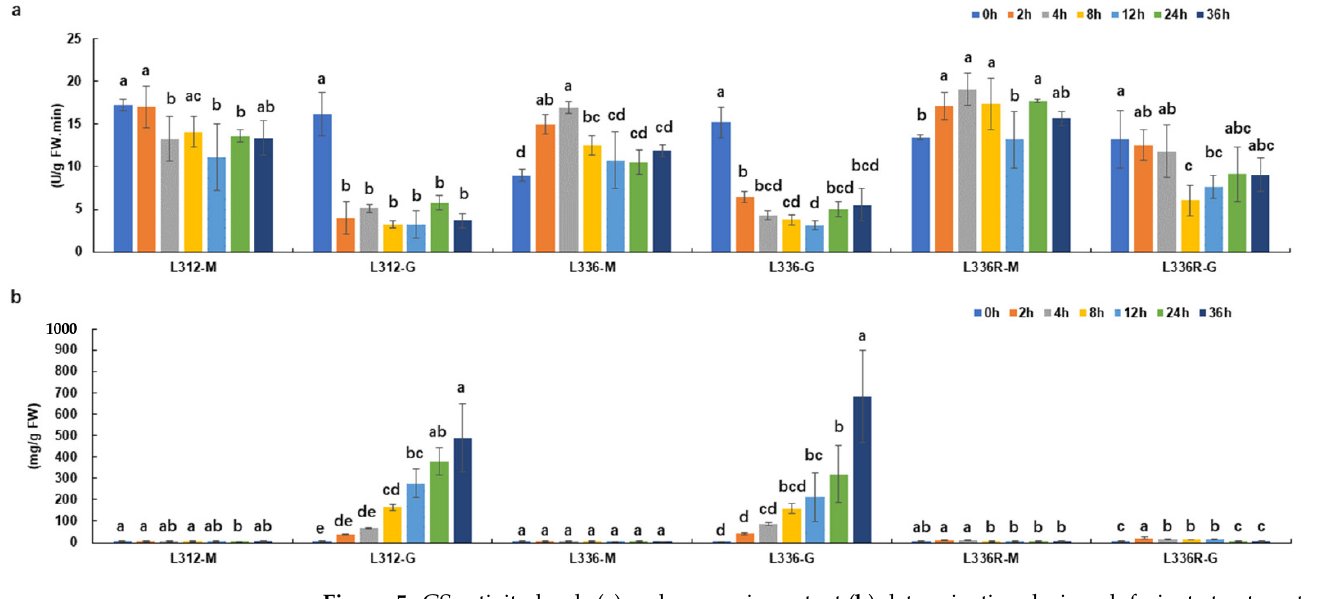
Figure 5. GS activity levels ( a ) and ammonia content ( b ) determination during glufosinate treat- ment. Different letters above each histogram bar indicate significant differences ( p < 0.05). M: mock; G: glufosinate.